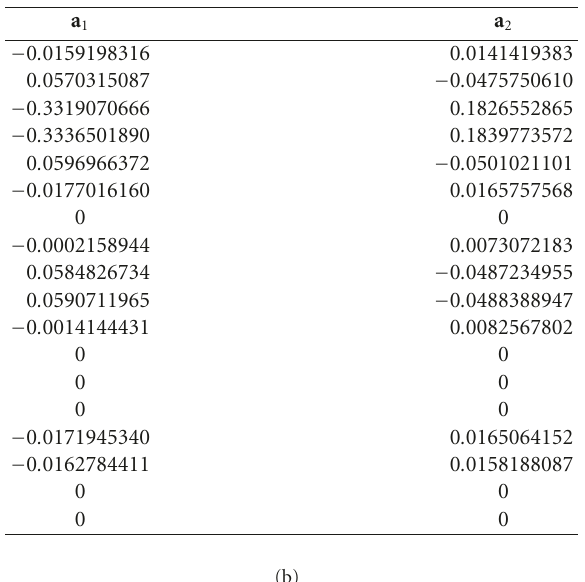
Table 2: Lifting-filter coe ffi cients for the (a) OPT1, (b) OPT3, and (c) OPT4 filter banks (where the coe ffi cient vectors { a i } are as de- fined in (10) and (15)) a 1 a